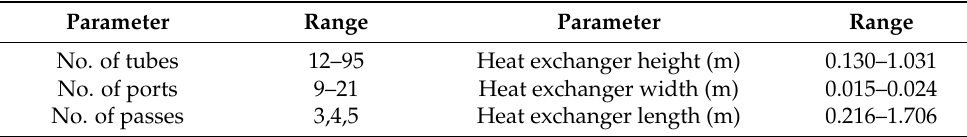
Table 3. Range of parameters for the optimization model.